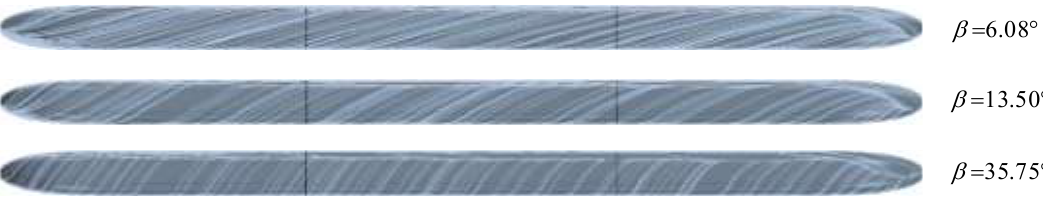
Figure 10. Streamlines on the top surface of train at different resultant yaw angles.